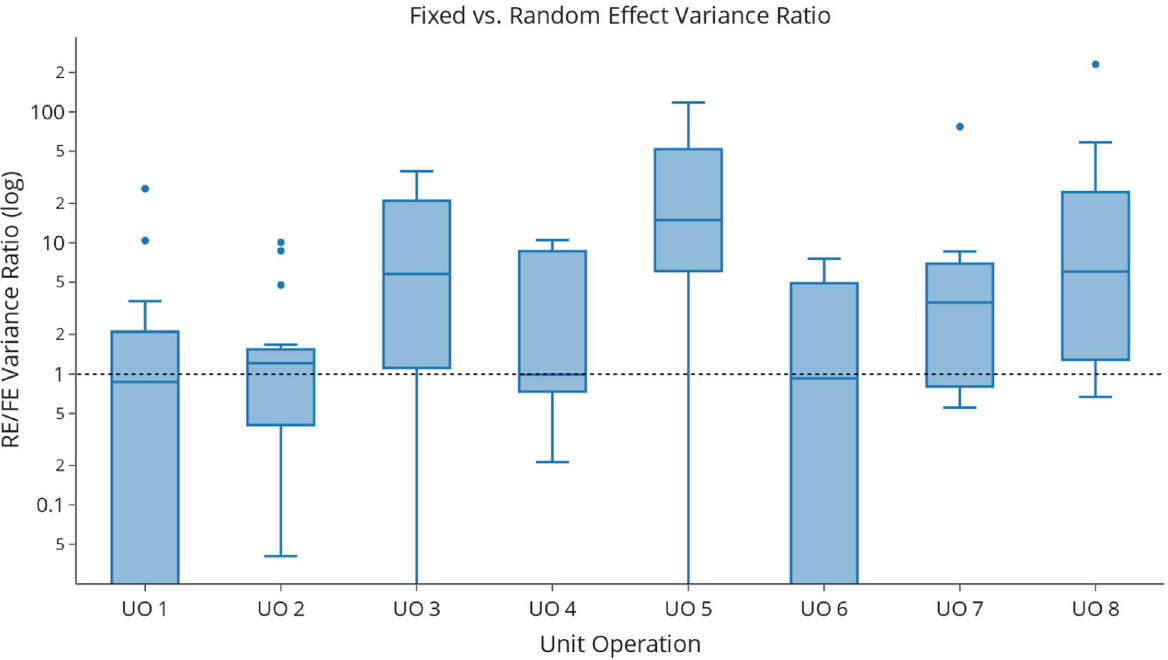
Fig. 4 Variance ratios (random variance/residual variance) are shown per unit operation on a logarithmic scale. For each model in a unit operation, the ratio between random and residual variance is calculated and the resulting distribution illustrated as a box plot. As random effect size increases, so does its contribution to variance — in some cases, the random contribution to variance is many times as large as the residual